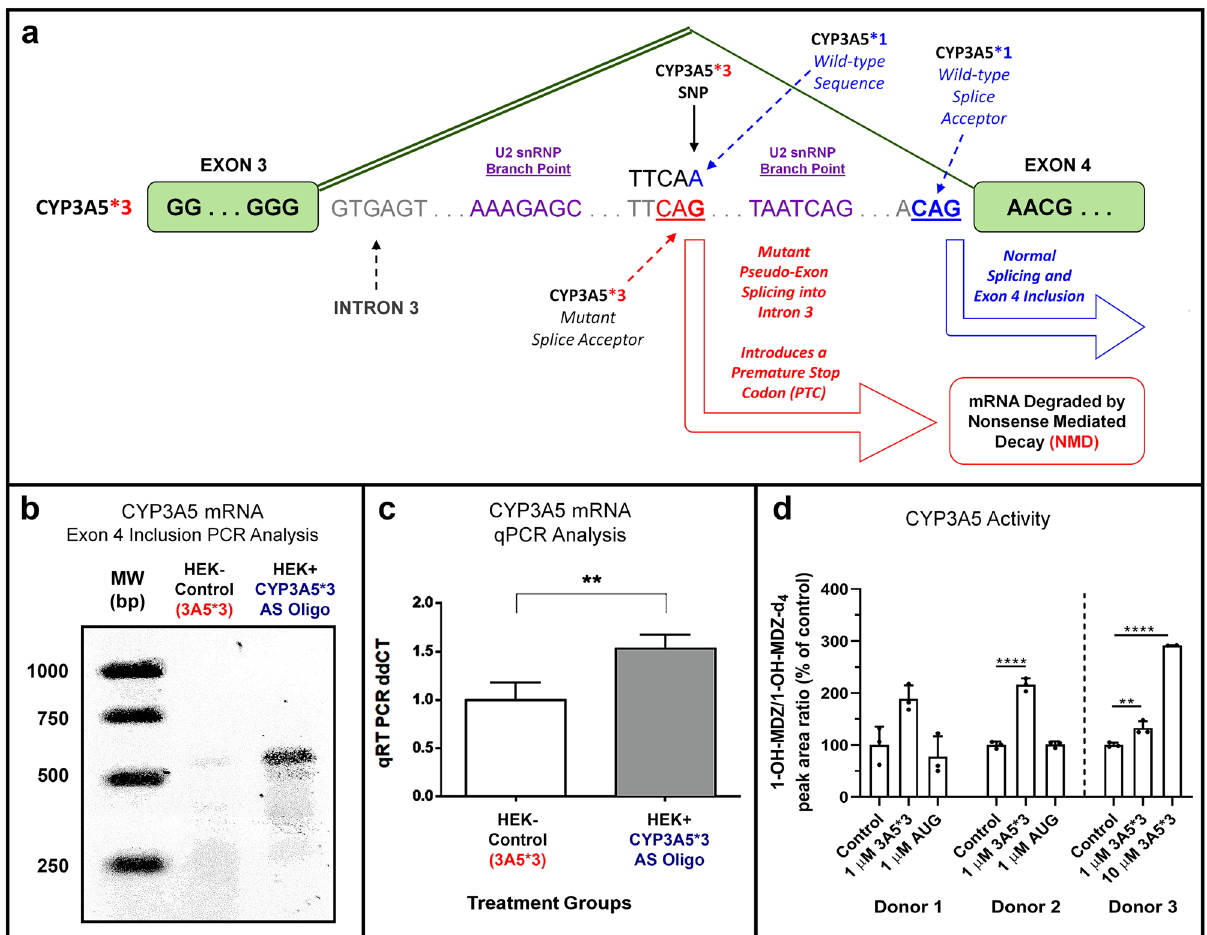
Figure 1. The CYP3A5*3 SNP Regulates Gene Splicing via a Salt-sensitive Mechanism that can be Modulated with ASO in Renal Cell Culture Models. ( a ) Schematic for the CYP3A5*3/*3 polymorphism found in HEK293 cells. The CYP3A5*3-SNP creates a cryptic splice acceptor within intron 3 that results in the aberrant splicing of a pseudo-exon containing a PTC that targets the mRNA transcript for degradation by NMD. Both the cryptic splice acceptor (CAG/TA) and the exon 4 splice acceptor (CAG/AA) are preceded by canonical U2 snRNP branch point cis -acting elements. ( b ) Endpoint PCR results monitoring exon 4 inclusion in mature CYP3A5 mRNA transcripts demonstrate the role of the *3-SNP in altering splicing and transcript stability. Wild-type CYP3A5 mRNA transcripts encoding exon 4 are virtually undetectable (no band) in HEK293 cell lysates under normal conditions, however when the *3-SNP site is masked by interactions with an antisense oligomer ( CYP3A5*3 PMO; 3 µM; 48 h) transcript stability is restored, leading to enhanced detection of exon 4 inclusion via endpoint PCR. ( c ) Quantitative PCR (qRT-PCR; SYBR green) results demonstrating a 1.5-fold increase in total CYP3A5 mRNA when HEK293 cells were treated with the CYP3A5*3 PMO (1 µM; 48 h). ( d ) Quantification of the formation of 1-OH-midazolam from midazolam by LC/MS/MS after treatment with either 3A5*3 PMO or AUG PMO for 6 days in primary human PTECs. CYP3A5 activity was increased in PTECs treated with 3A5*3 PMO but not AUG PMO (** p < 0.01; t-test). Efficiency of restoration of CYP3A5 activity by the 3A5*3 PMO was donor-dependent (Donor 3; See Supplemental Table 1), and was not related to cellular toxicity, as PMO treatments did not alter normal PTEC morphology (see Supplemental Fig. with a splice acceptor site in intron 3, with an intron/exon sequence (CAG/TA), that can compete with the refer- ence sequence (CAG/AA) at the authentic exon 4 splice acceptor site (Fig. 1a). In addition, a U2 snRNP branch point sequence (AAA GAG ) found upstream from the *3-SNP , resembles the reference branch point (AAT CAG ) near the exon 4 splice acceptor. Incorrect splicing of exon 4 at the *3 SNP site creates a pseudo-exon with a termination codon, located upstream of the exon 4 splice acceptor site, capable of triggering NMD and loss of the CYP3A5 mRNA. To validate the role of the 6896A/G polymorphism in creating the cryptic splice acceptor site in intron 3, an antisense oligonucleotide designed to bind to the SNP site was prepared, 3A5*3 PMO (Table 1). To clarify the role of the *3-SNP in promoting NMD of mature transcripts, we explored the nature of CYP3A5 mRNA expression in a human embryonic kidney (HEK293) cell line, which was verified as homozygous *3/*3 by DNA sequencing (Supplemental Fig. 1b). Incubation of HEK293 cells with the 3A5*3 PMO (1 µM; 48 h), which masks the cryptic splice acceptor, led to increased levels of CYP3A5 mRNA as revealed by both endpoint PCR